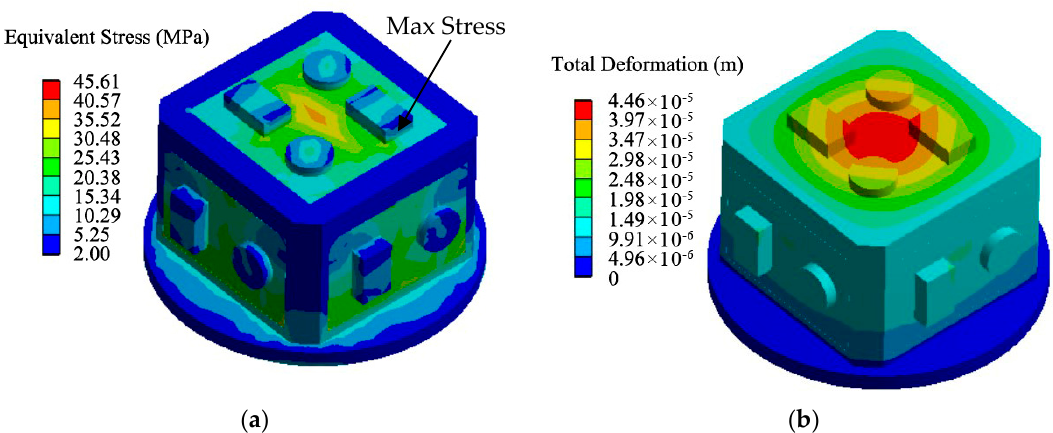
Figure 5. Three-dimensional stress analysis diagram of the test device: ( a ) Equivalent stress; ( b ) Total deformation.